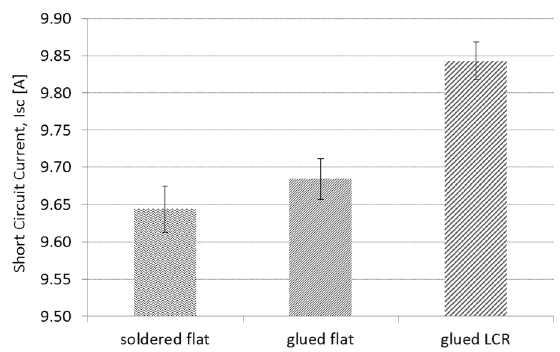
Fig. 8. Soldered standard ribbons compared to glued flat and glued LCRs in a cell flash tester.